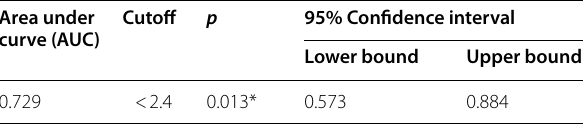
Table 4 Receiver operating characteristics (ROC) curve for prediction of coronary artery disease. Area under curve (AUC) of sirtuin1 regarding coronary artery disease: